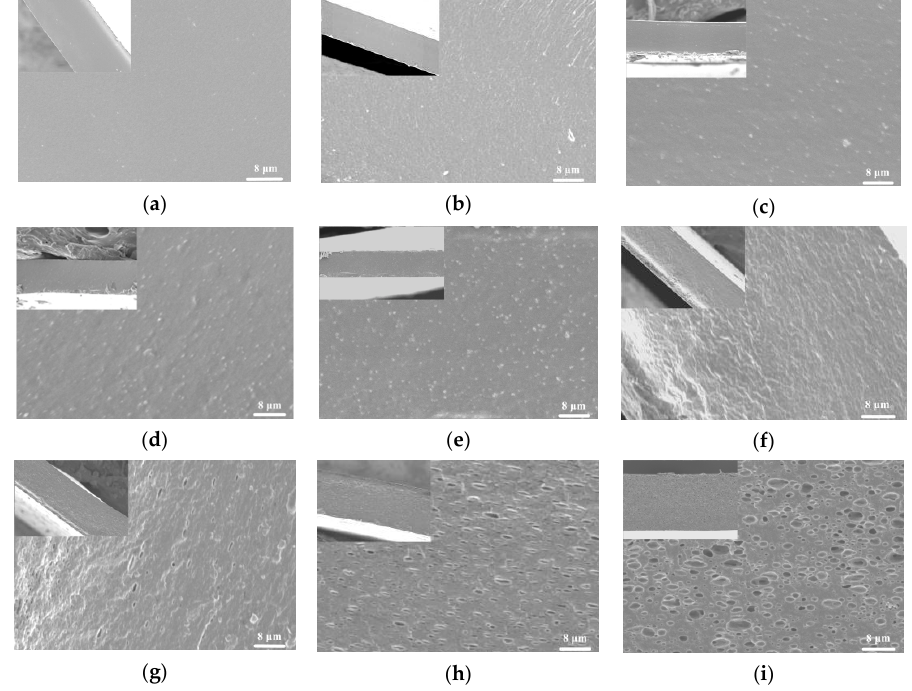
Figure 2. SEM micrographs of cross sections of films. ( a ) Control; ( b ) 1% TiO 2 -N; ( c ) 3% TiO 2 -N; ( d ) 5% TiO 2 -N; ( e ) 7% TiO 2 -N; ( f ) 3% CO-3% TiO 2 -N; ( g ) 6% CO-3% TiO 2 -N; ( h ) 9% CO-3% TiO 2 -N; and ( i ) 12% CO-3% TiO 2